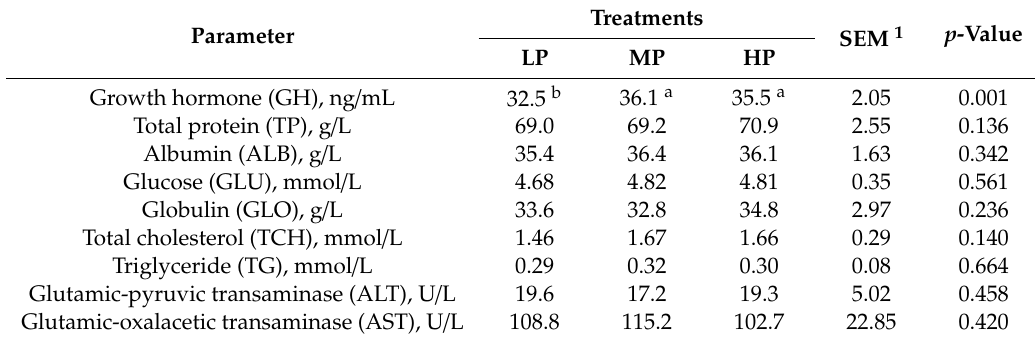
Table 4. E ff ects of three di ff erent dietary protein levels on serum metabolites in Tibetan sheep (n = 6 per group).